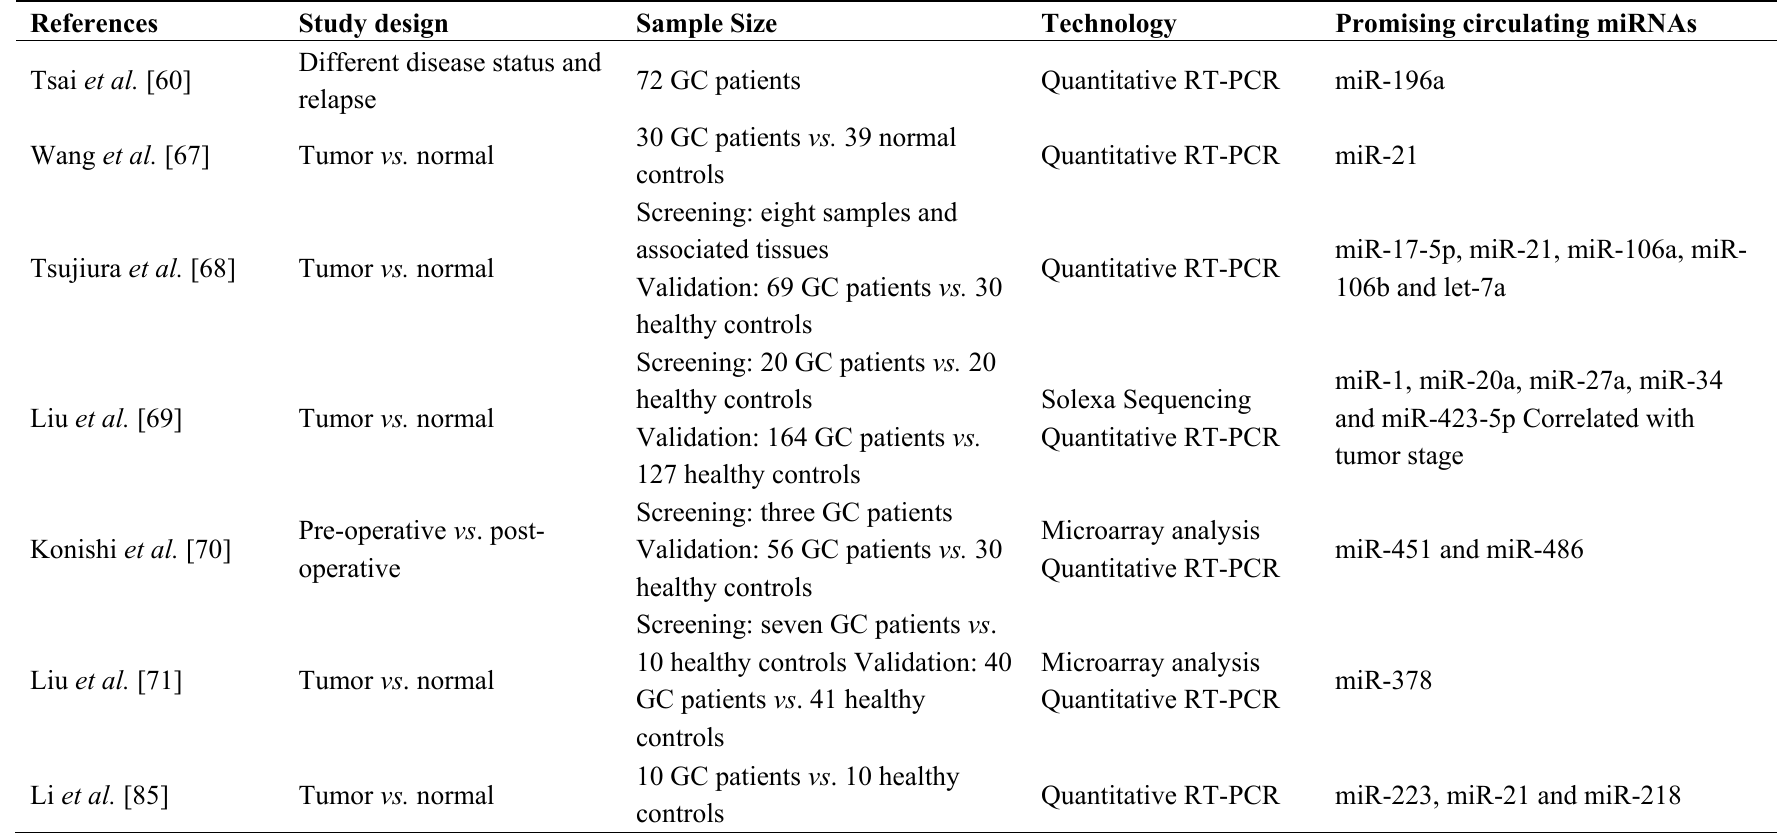
Table 2. Circulating miRNAs in the serum as diagnostic markers for gastric